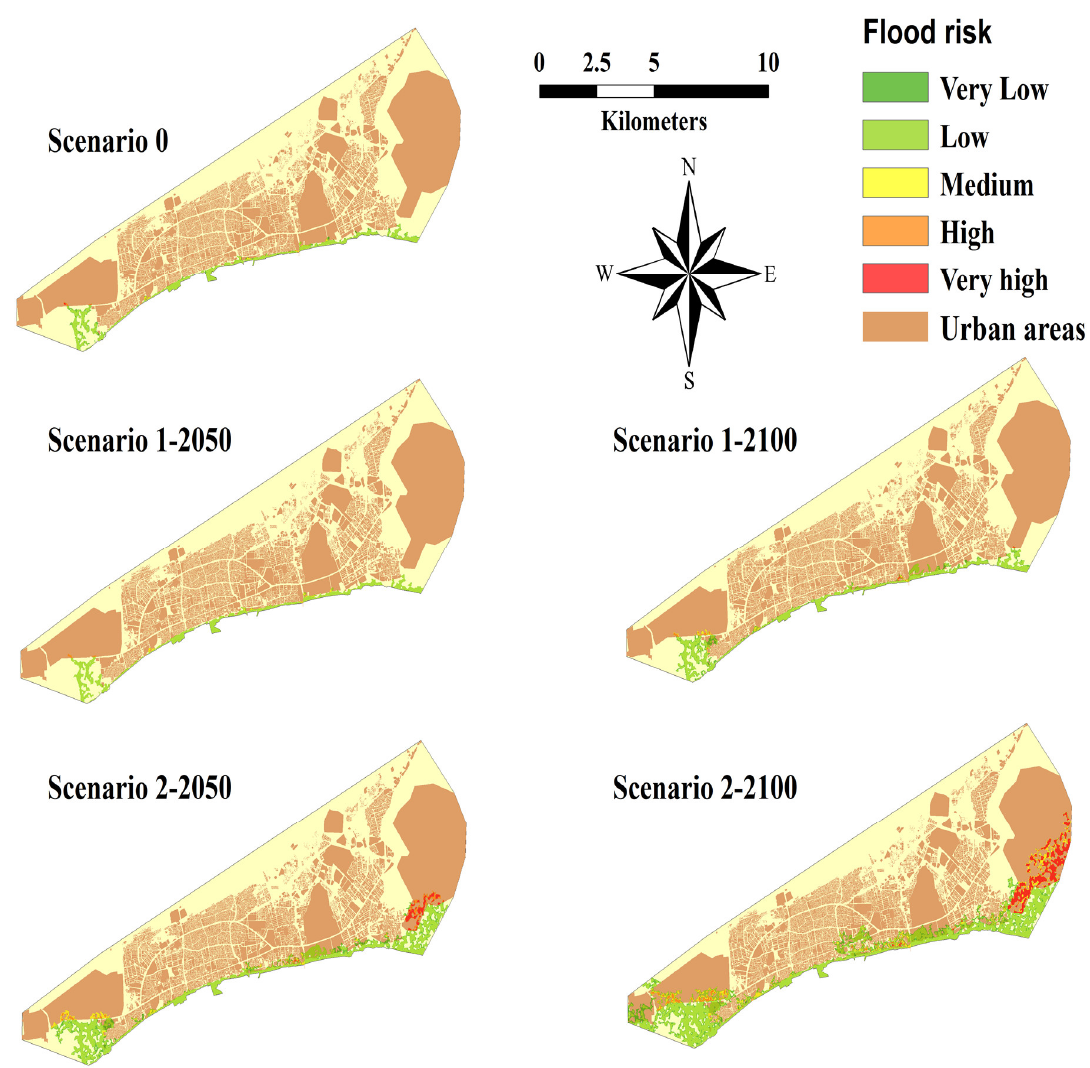
Table 7. Percentage area of risk classes for various coastal flooding scenarios.